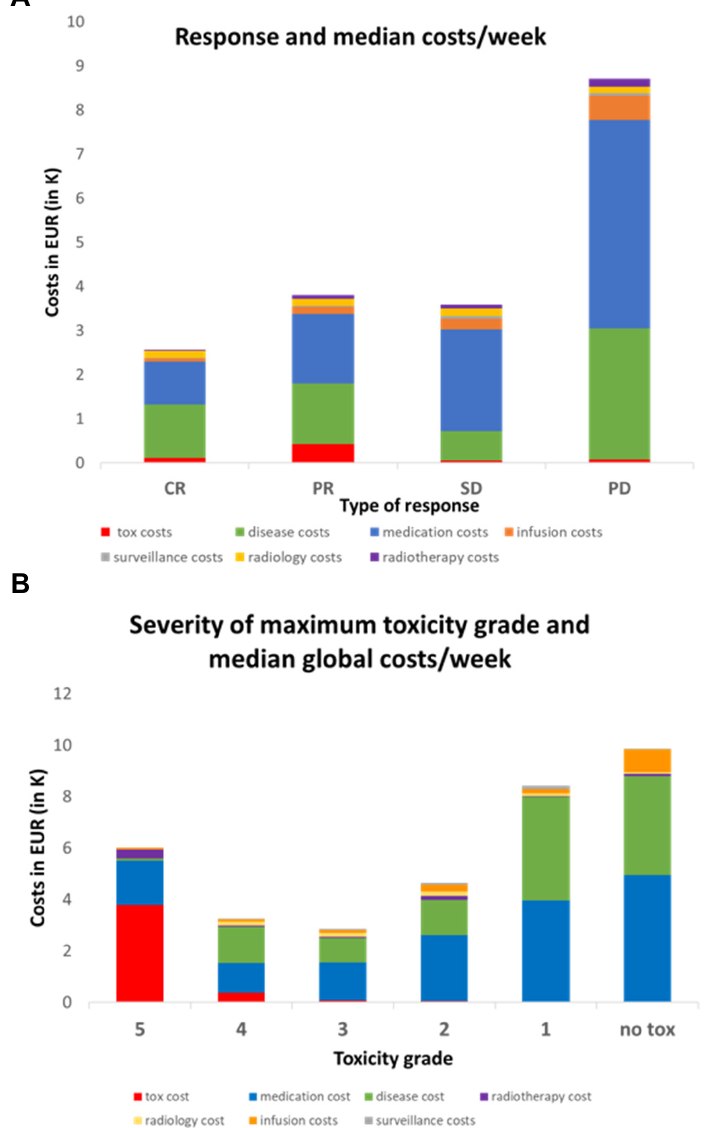
Figure 5. ( A ) Relationship between median cost per week and best overall response following RECIST 1.1. CR: complete response, PR: partial response, SD: stable disease, PD: progressive disease. ( B ) Relationship between median cost per week and maximum toxicity grade.